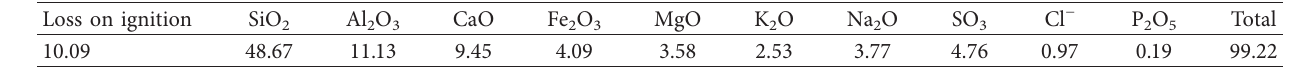
Table 2: Chemical composition of saline soil (% by weight).